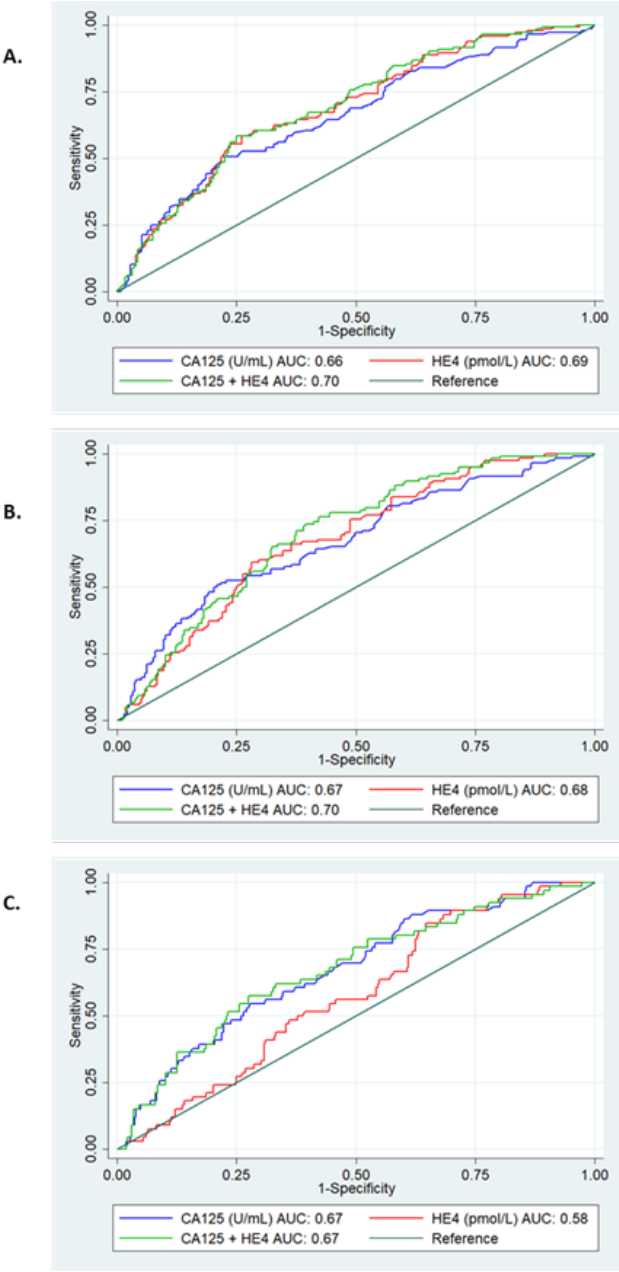
Figure 2. ROC curve analysis of serum markers for the detection of high-risk features of endometrial cancer. (A)—Myometrial invasion. CA125 AUC 0.66 (95% CI 0.61–0.72), HE4 AUC 0.69 (95% CI 0.64–0.74), combined AUC 0.70 (95% CI 0.64–0.75), p = 0.01. (B)—LVSI. CA125 AUC 0.67 (95% CI 0.61–0.73), HE4 AUC 0.68 (95% CI 0.62–0.73), combined AUC 0.70 (95% CI 0.65–0.76), p = 0.006. (C)—Cervical stromal invasion. CA125 AUC 0.67 (95% CI 0.60–0.74), HE4 AUC 0.58 (95% CI 0.51–0.64), combined AUC 0.67 (95% CI 0.60–0.74), p = 0.02.